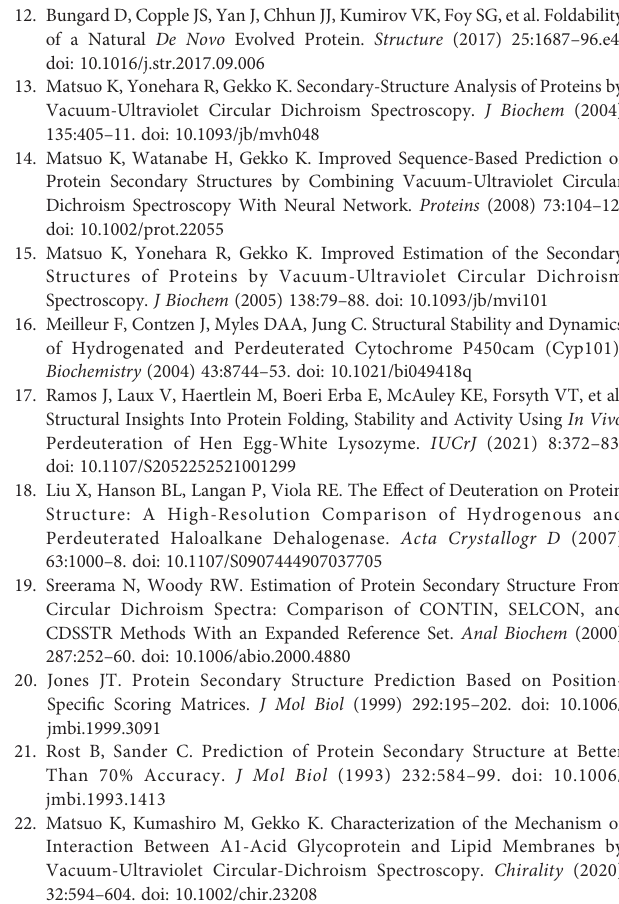
are shown. a -Helix, b -strand, and other structures are shown in red, yellow, and gray, respectively. (B) Contents of a -helix, b -strand, and other structures estimated using the prediction methods used in (A) . N helix and N strand denote the number of a -helix and b -strand, respectively. Supplementary Figure 2 | Secondary structure of hydrogenated SUMO-tagged NCYM (H_Tag_NCYM), perdeuterated SUMO-tagged NCYM (D_Tag_NCYM), hydrogenated SUMO tag (H_Tag), and perdeuterated SUMO tag (D_Tag) predicted by the neural network. Note that in the region I119 – P133 of H_Tag_NCYM, there are two b -strands, that is, I119 – G128 and G129 – P133. The residues belonging to the disordered b -strand, which are assigned by the neural network, correspond to the edges of the b -strands (I119, G128, G129, and P133 in this case). The fraction of the ordered and disordered b -strand is listed in Table 1 . Supplementary Figure 3 | Comparison of the structure of NCYM between the present study and previous report. Supplementary Figure 4 | NCYM forms oligomers. (A) Puri fi cation of NCYM. (B) Western blotting showing the monomer, dimer, trimer, and tetramer structures of puri fi ed NCYM in non-reducing conditions, but the protein did not form an oligomer under reducing conditions. (C) Western blots showing monomer, dimer, trimer, tetramer, and pentamer structures of NCYM from IMR32 cells. (D) Western blotting of nuclear and cytoplasmic fractions from IMR32 cells. Monomers and oligomers of NCYM were found in the nucleus cytoplasm, respectively. Supplementary Table 1 | Single-nucleotide polymorphisms (SNPs) in NCYM